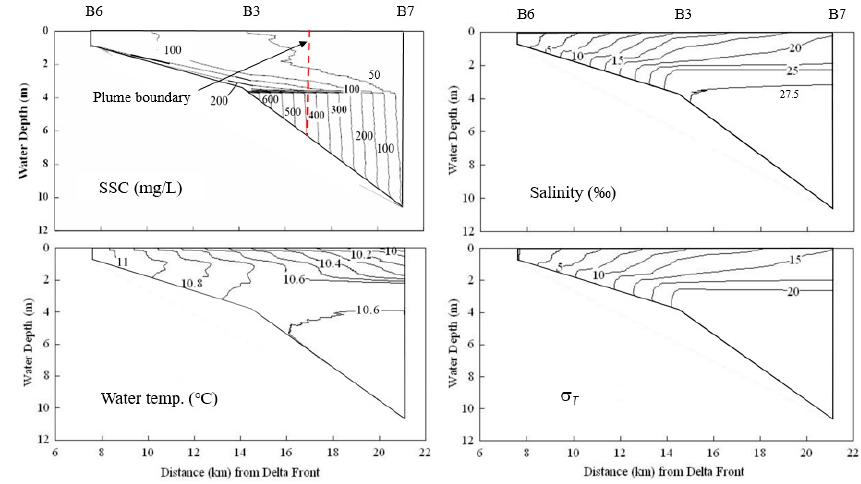
Figure 5. Longitudinal cross-sections of SSC, water temperature, salinity, and water density σ T by the coastal observation on the B6–B7 line on 6 September 2009 (Figure 1). The dotted line in the SSC cross-section shows a boundary between turbid plume water and relatively clean ocean water observed in situ.